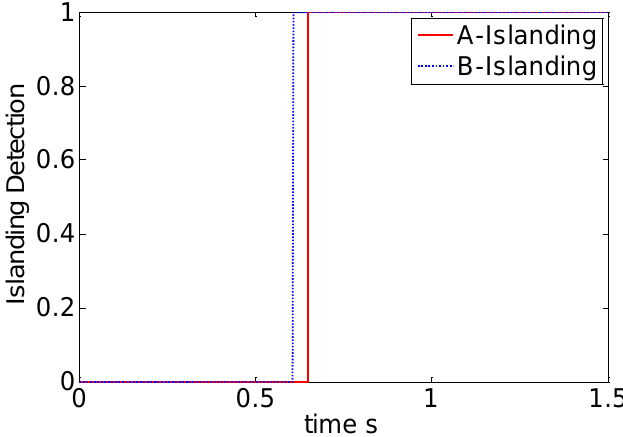
Figure 7. Islanding detection signal for case 1, scenario A and B.